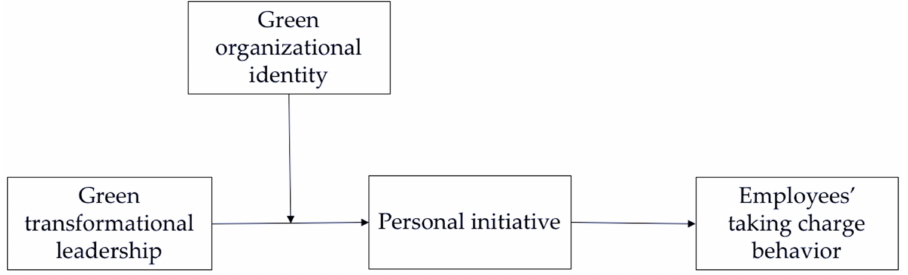
Figure 1. Proposed